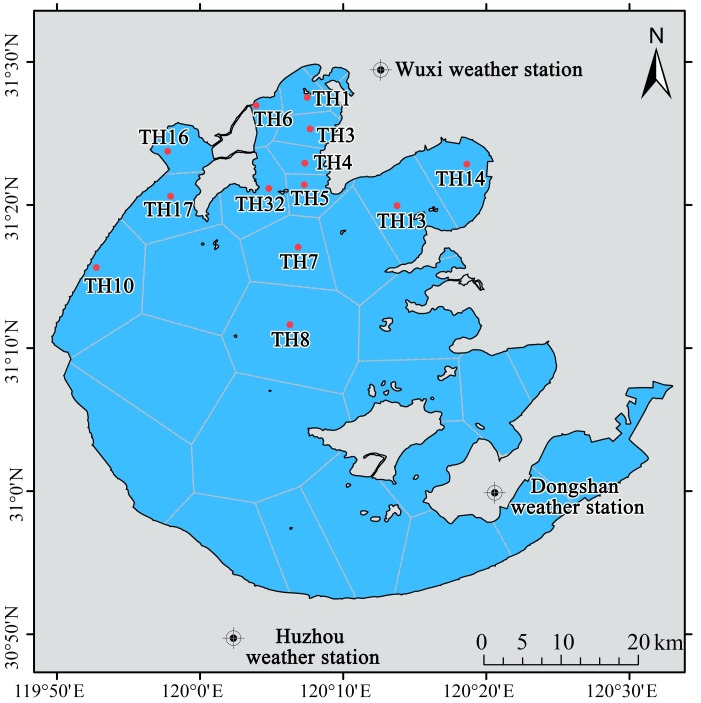
Weather stations and water quality sampling sites in Lake Taihu.Weight factors were calculated based on the relative polygon size to the total area of Lake Taihu. Monthly sampling sites with red dots indicating locations included in the present study. The figure is for illustrative purposes only.